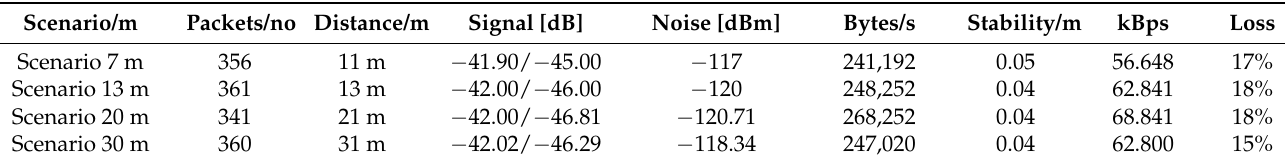
Table 4. Simulation scenarios at a distance of 30 m from reception, data interpretation, losses, data transfer, signal, and noise.